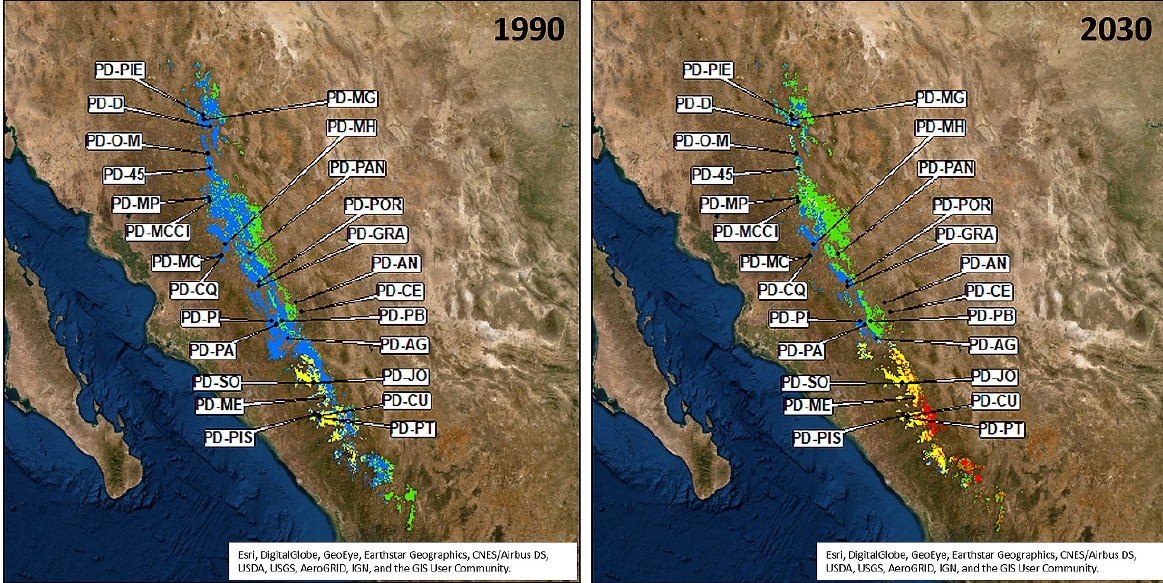
Figure 5. Projection of seed zones distribution for Pinus durangensis for 1990 and 2030 climatic frames, based on the relative frequency of AFLP outliers (240 and 416); modelling based on spring and winter precipitation (mm) (see Table 1); the species distribution was modeled by 21 environmental variables using the Random Forest classifier (Tables S8, S9 and S10a,b). The threshold for probability of presence (PoP) was 0.35; black points = P. durangensis seed stands studied (Table S3b); green color = relative frequency of the adaptive AFLP-240 assumption between 0 and 0.50; red color = relative frequency of the adaptive AFLP-240 assumption between 0.51 and 1; blue color = relative frequency of the AFLP outlier locus 416 assumption between 0 and 0.50; and yellow color = relative frequency of the AFLP outlier locus 416 assumption between 0.51 and